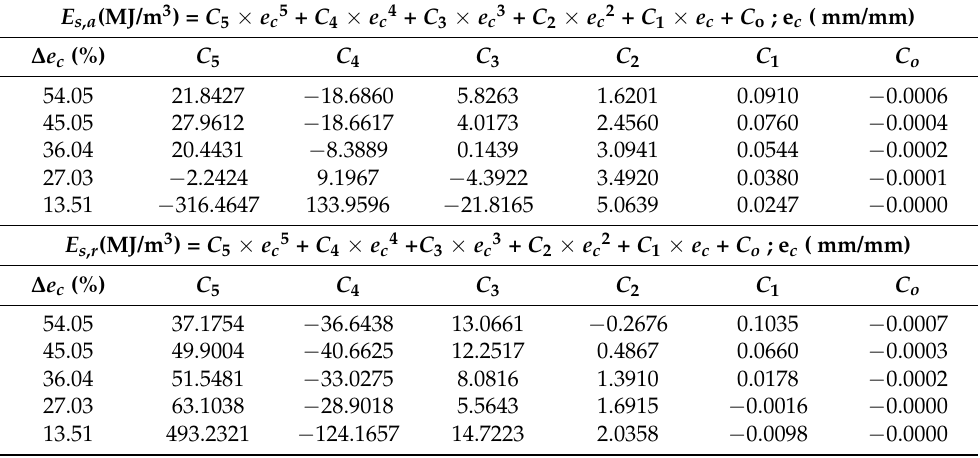
Table 2. Polynomial regression coefficients for E s , a ( e c ) and E s , r ( e c )